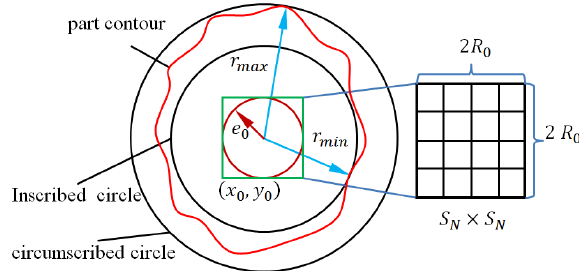
Figure 4. Initialization of the local regional population average.